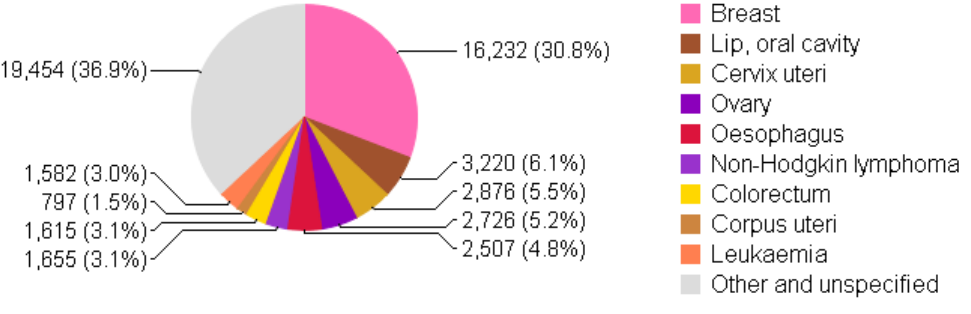
Figure 2. Mortality due to cancer in females of all ages in Pakistan (per 100,000) (chart adapted from